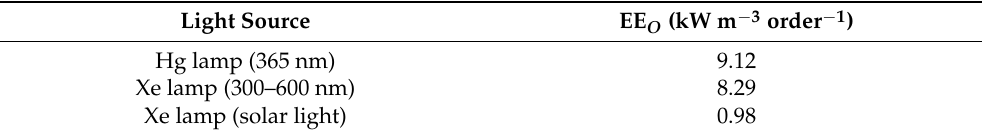
Table 3. EE O estimated for different type of lamps.